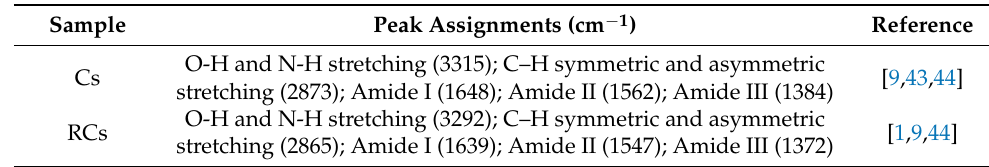
Figure 2. FTIR spectra of Cs and RCs. Table 1. FTIR bands of Cs and RCs with peak assignments.